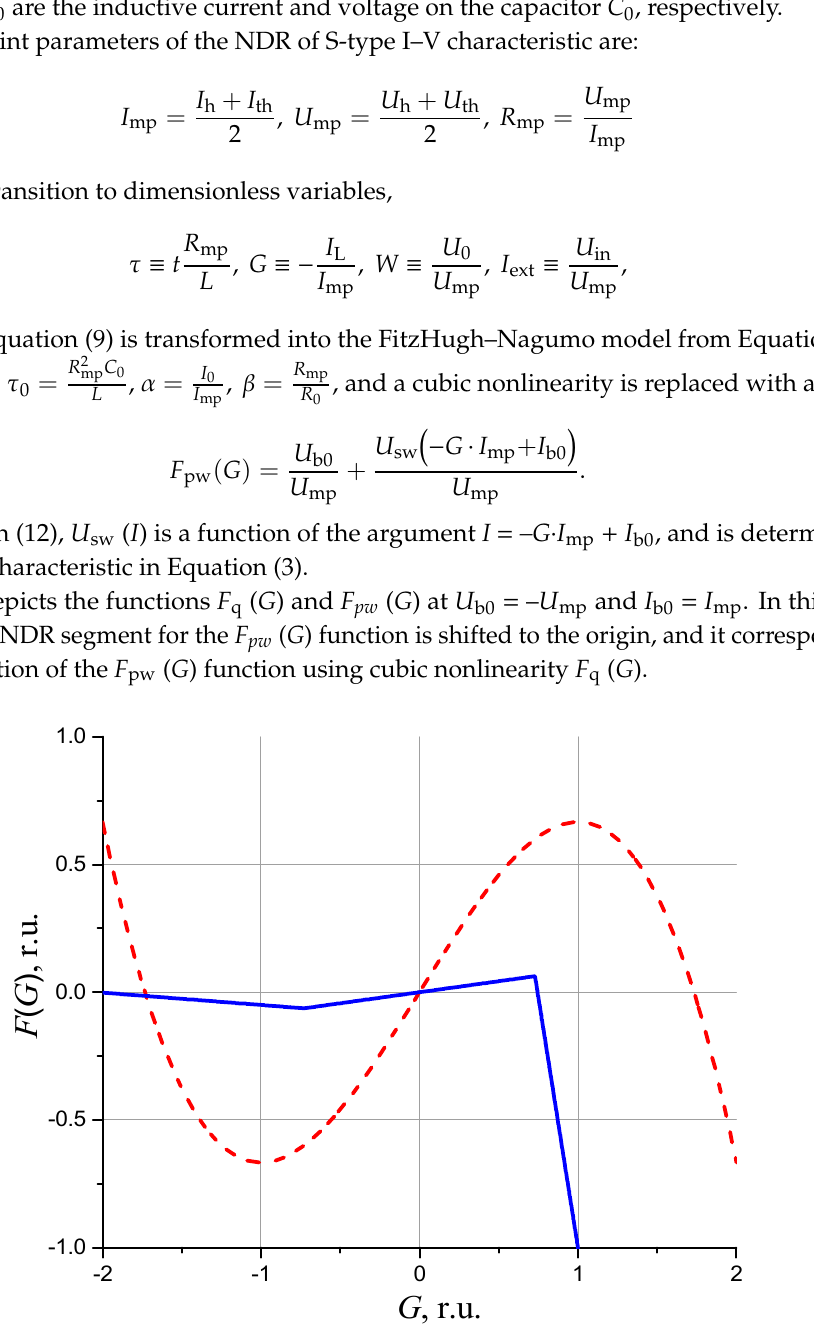
Figure 7. The functions of potential F ( G ) for cubic nonlinearity F q ( G ) (dash, red) and piecewise linear approximation of F pw ( G ) from Equation (12) at I b0 = I mp and U b0 = – U mp (solid, blue), using the example of I–V characteristic of NbO 2 switch (Figure 3).